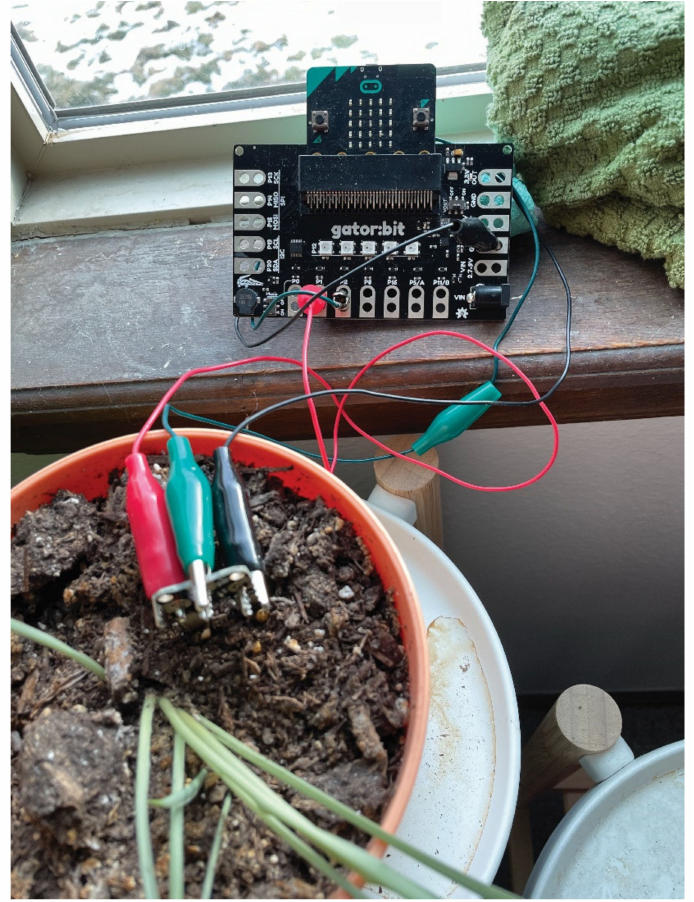
Figure 5. DaSH measuring soil